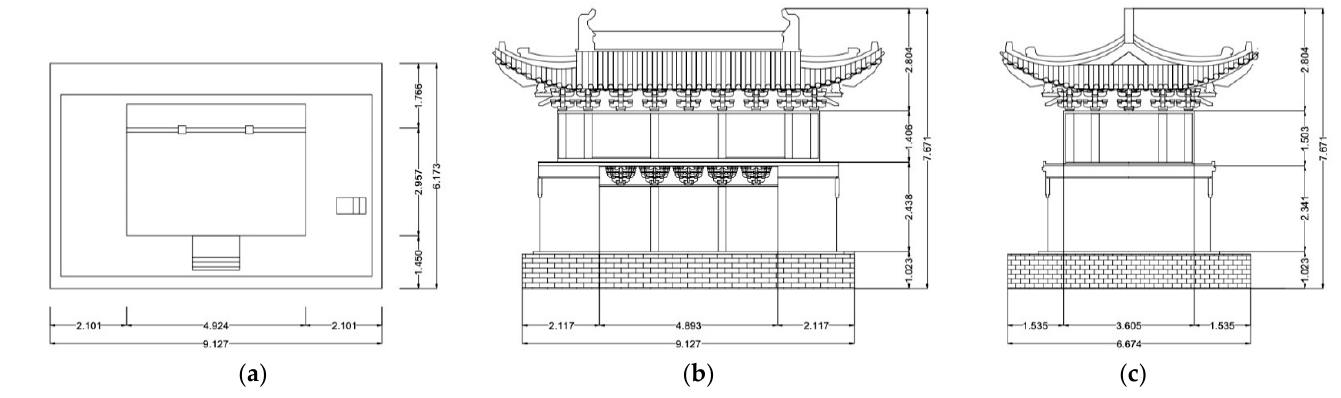
Figure 10. CAD drawing of the Sutra Pavilion: ( a ) plane, ( b ) façade, and ( c ) side elevation. Table 2. Bucket arch information table.